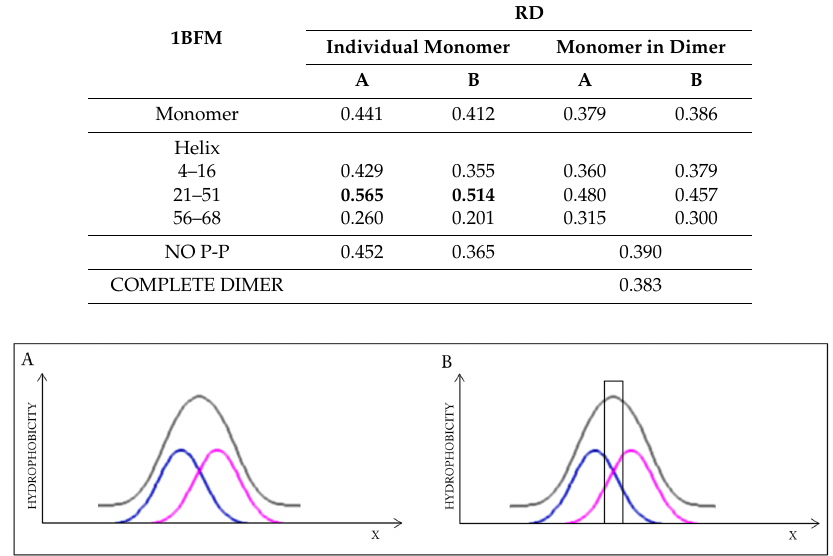
Figure 1. Schematic depiction of a system in which the dimer as well as its individual monomers contain well-defined hydrophobic cores. Elimination (black bar on the right profile) of residues involved in complexation distorts the dimeric core. Blue and pink lines: distributions in monomers, gray line: distribution in dimer. ( A ) Status of the individual monomers ( blue and pink ) versus the resultant distribution in dimer ( gray ); ( B ) The removal of the interface ( black bar ) does not change the status of the dimer—Distribution accordant versus the expected one.